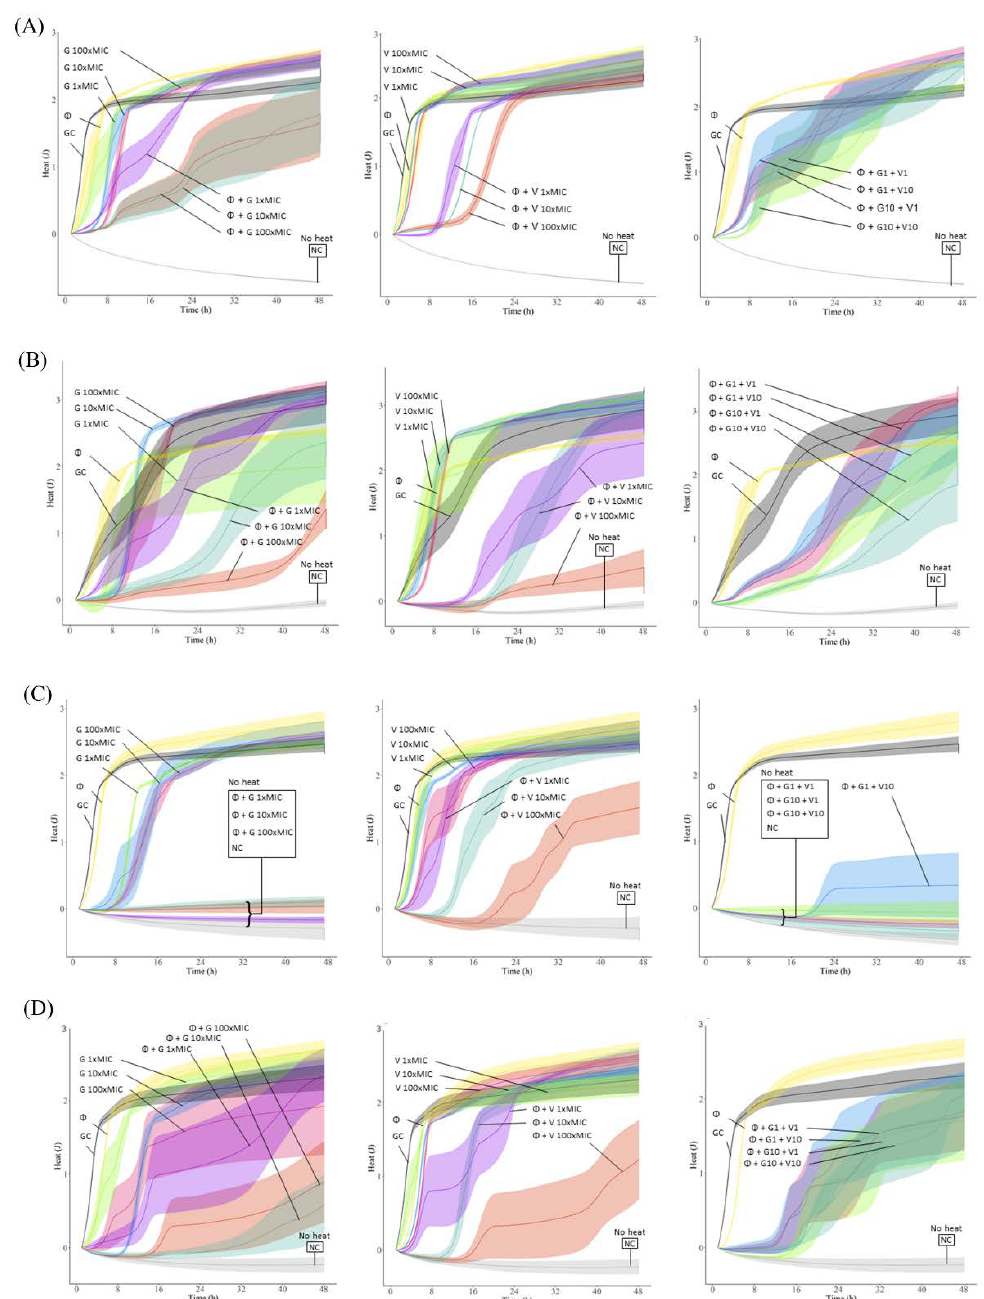
Figure 4. Heat (J) curves of E. faecalis ( A ) EF 03, ( B ) EF 06, ( C ) EF 10 and ( D ) EF 14 biofilms exposed to phage (Φ at 10 8 PFU/mL), gentamicin (G), or vancomycin (V) at different concentrations (1×, 10× or 100× MIC), or with staggered phage-antibiotic combinations (Φ + antibiotic). Each curve shows the heat produced over time by viable bacteria in the biofilm after 24 h of treatment. GC represents the growth control sample not exposed to any antimicrobials. NC represents de negative control for media sterility. Data are expressed as mean ± SE. Plots were prepared using RStudio [30]. Solid lines represent the mean and corresponding shaded regions the standard error.